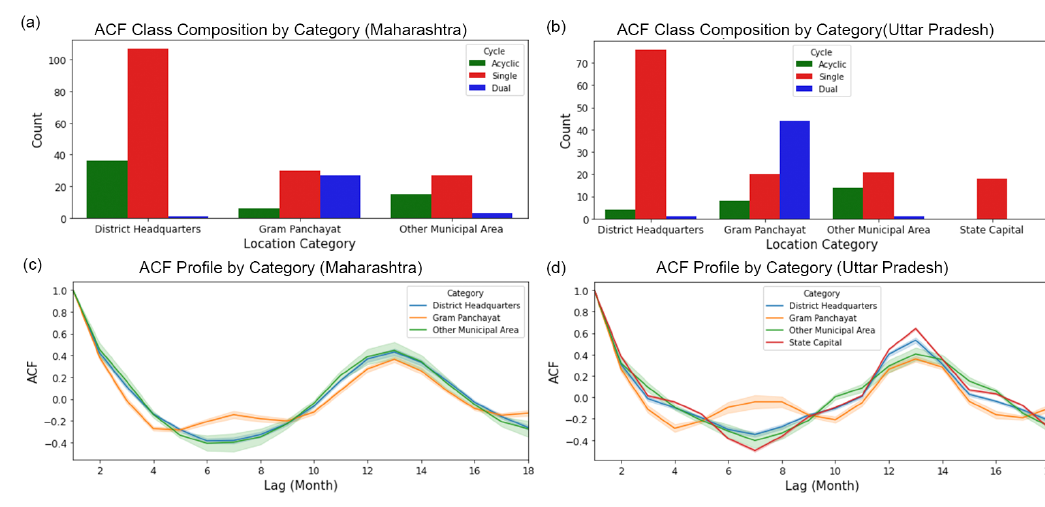
Figure 28. ACF classes and profiles for each Prayas voltage monitoring location category. ( a ) ACF class composition by location category in Maharashtra. ( b ) ACF class composition by location category in Uttar Pradesh. ( c ) Average ACF profile for each location category in Maharashtra. ( d ) Average ACF profile for each location category in Uttar